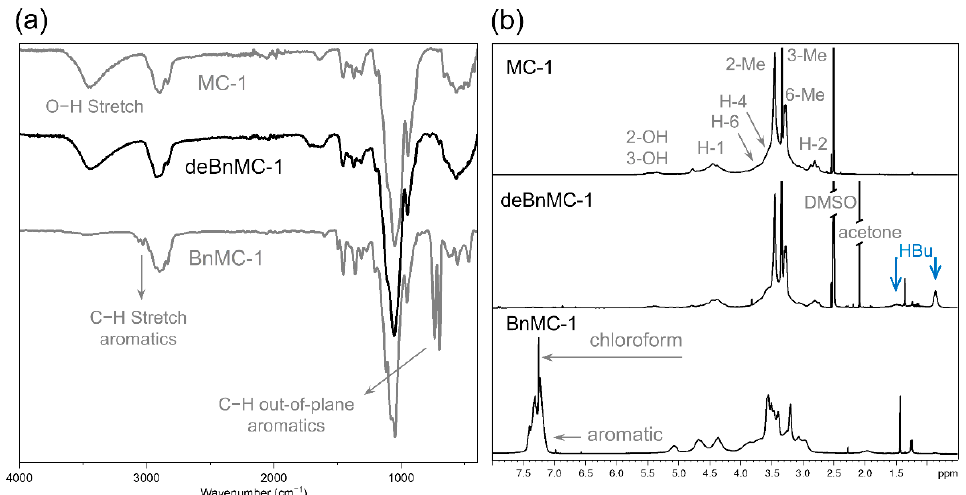
Figure 2. ( a ) ATR-IR spectrum of deBnMC-1 (Method-1, Table 1). Spectra of MC-1 and BnMC-1 are shown for comparison. ( b ) 1 H NMR spectra of MC-1 (600 MHz, DMSO- d 6 ), deBnMC-1 (300 MHz, DMSO- d 6 ), and BnMC-1 (300 MHz, CDCl 3 ).